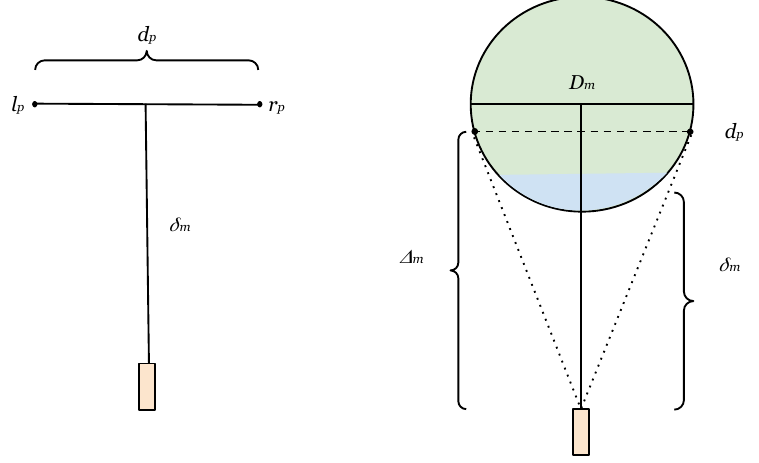
Figure A2. Diagram showing different methods of the approximate tree diameter. Left: Bird’s-eye- view diagram representing a simple approximation of the ToF sensor (colored orange) pointed at a tree. The left and right boundary lines determined in Section 2.3.2 are pointing straight up out of the page at the points labeled l p and r p . We can approximate the tree diameter in pixels, d p , as the number of pixels between them. In this simple approximation, we assume that the diameter line is at a distance δ m from the sensor, where δ m is the approximate trunk depth calculated in Section 2.3.1. Right: Modified bird’s-eye-view diagram of the ToF sensor pointing at a trunk. Since the tree is three-dimensional and roughly cylindrical, the left and right boundary lines found in Section 2.3.2 lie on a cylinder (shown here as a circle) around the trunk. d p , the distance between the left and right boundaries, is not the diameter of this cylinder, D m , but rather the length of a chord slightly closer to the ToF sensor than the true diameter. This is because of the field of view of the ToF sensor (represented by dotted lines). δ m , the approximate depth of the trunk found using the mode depth in the center third of the image (Section 2.3.1), does not correspond to ∆ m , the depth of the chord d p , but instead to a smaller depth somewhere in the blue region at the front of the